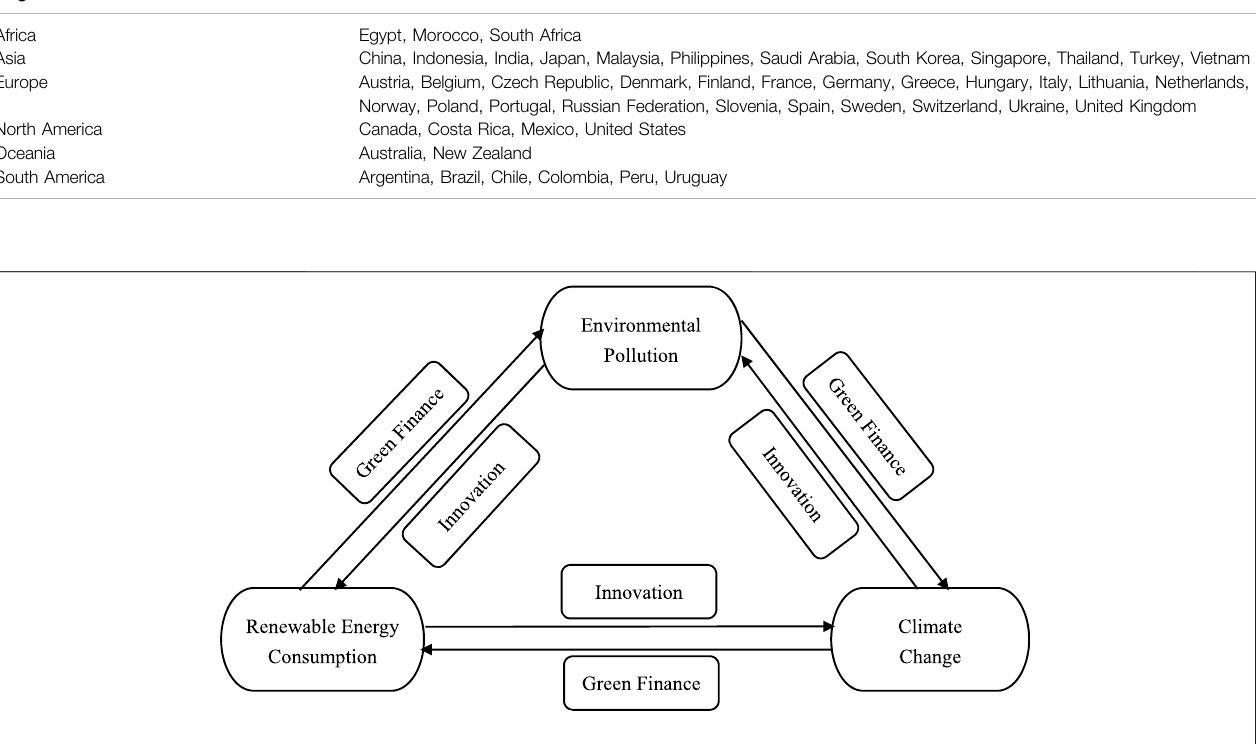
FIGURE 1 | Theoretical